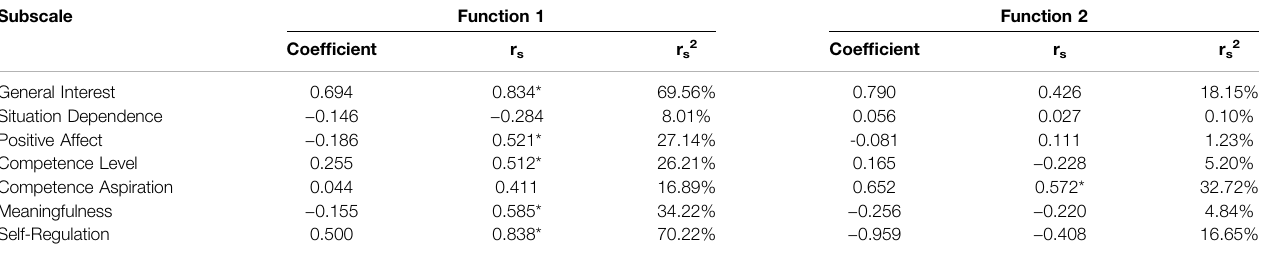
General Interest